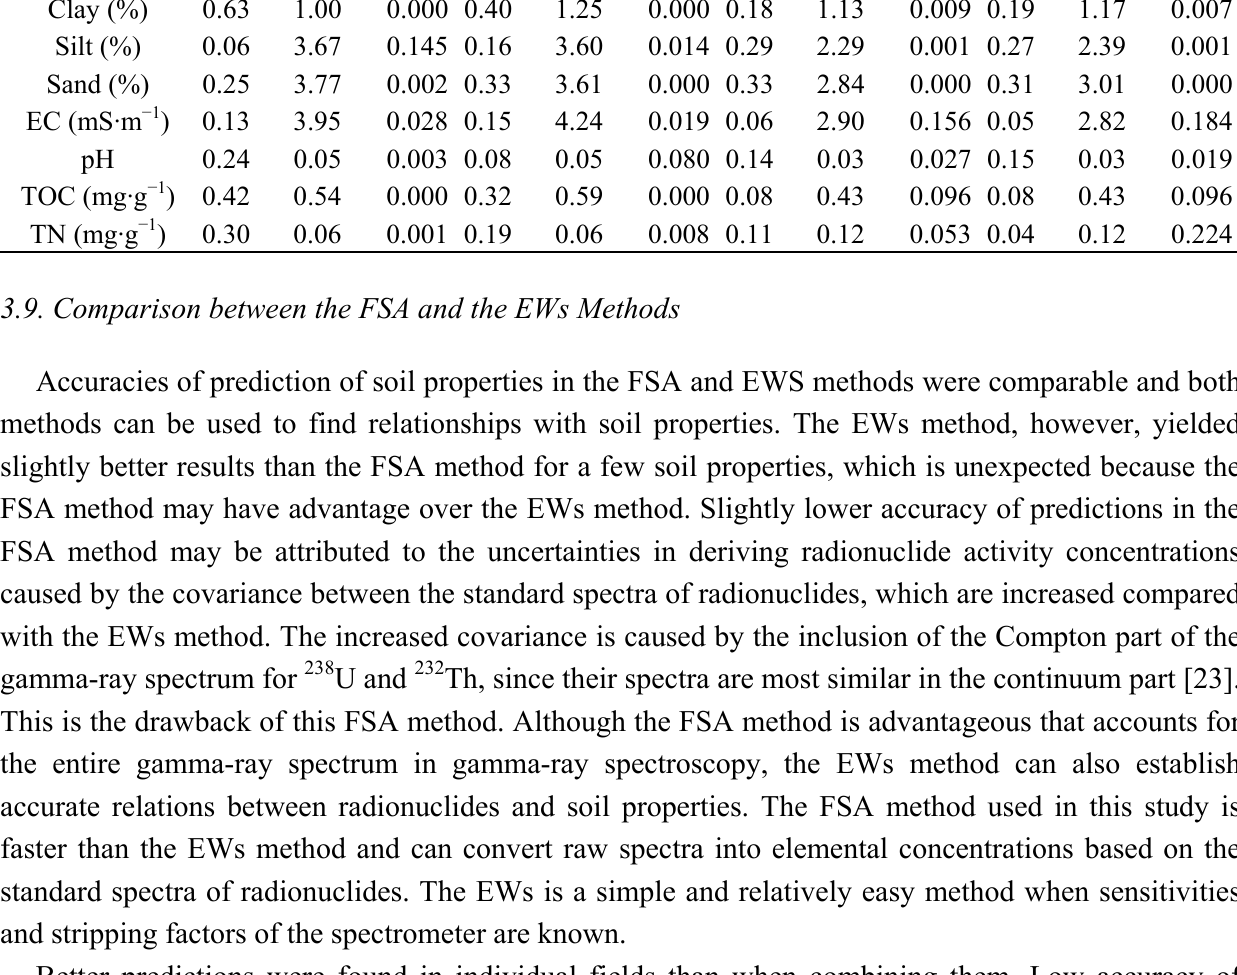
Table 7. Statistics of validation/predictions for combined fields using the FSA and the EWs methods.